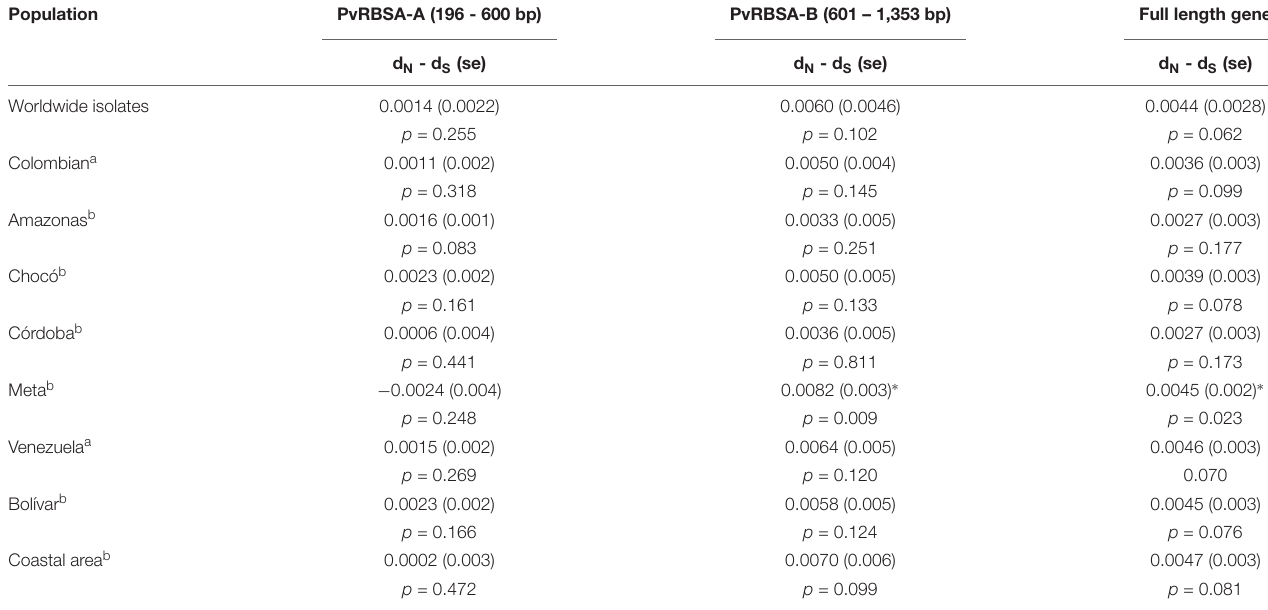
TABLE 3 | d N -d S difference within P. vivax.